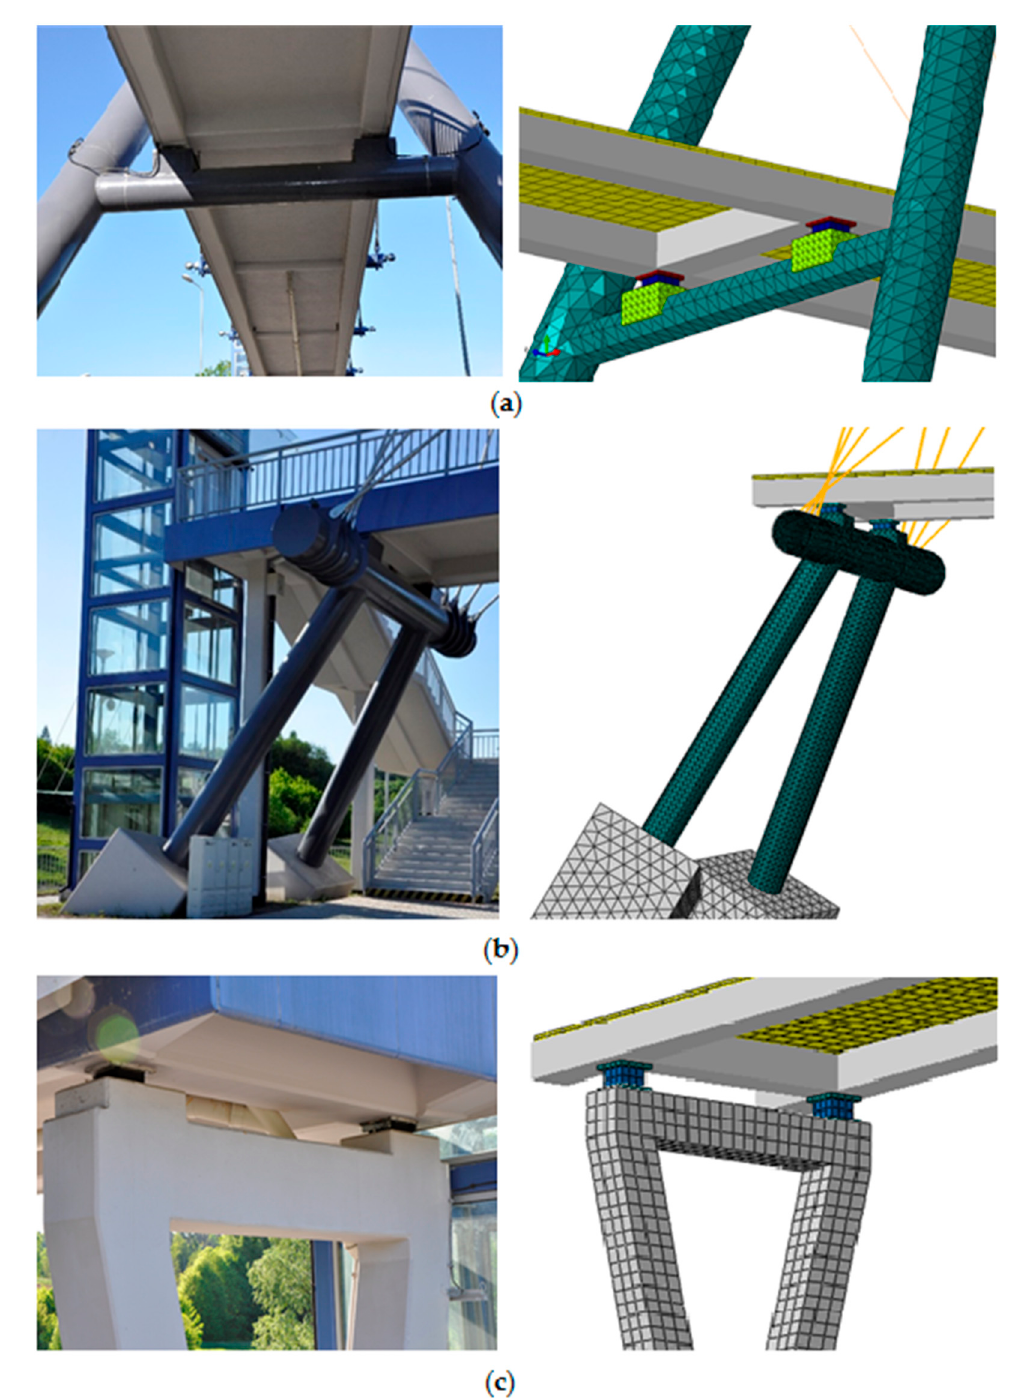
Figure 3. The structural details of the footbridge and the FE model: ( a ) the pylon arms tied by horizontal pipe with the crossbar supporting the deck; ( b ) the footbridge deck located on the steel beam anchoring the suspension strings; ( c ) the reinforced concrete V-shaped support.